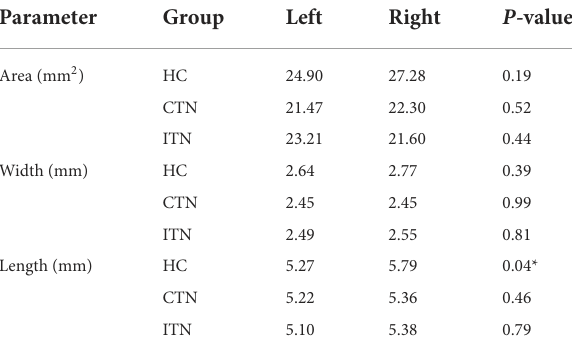
TABLE 2 Comparisons of parameters between the left and right sides in HC, CTN and ITN